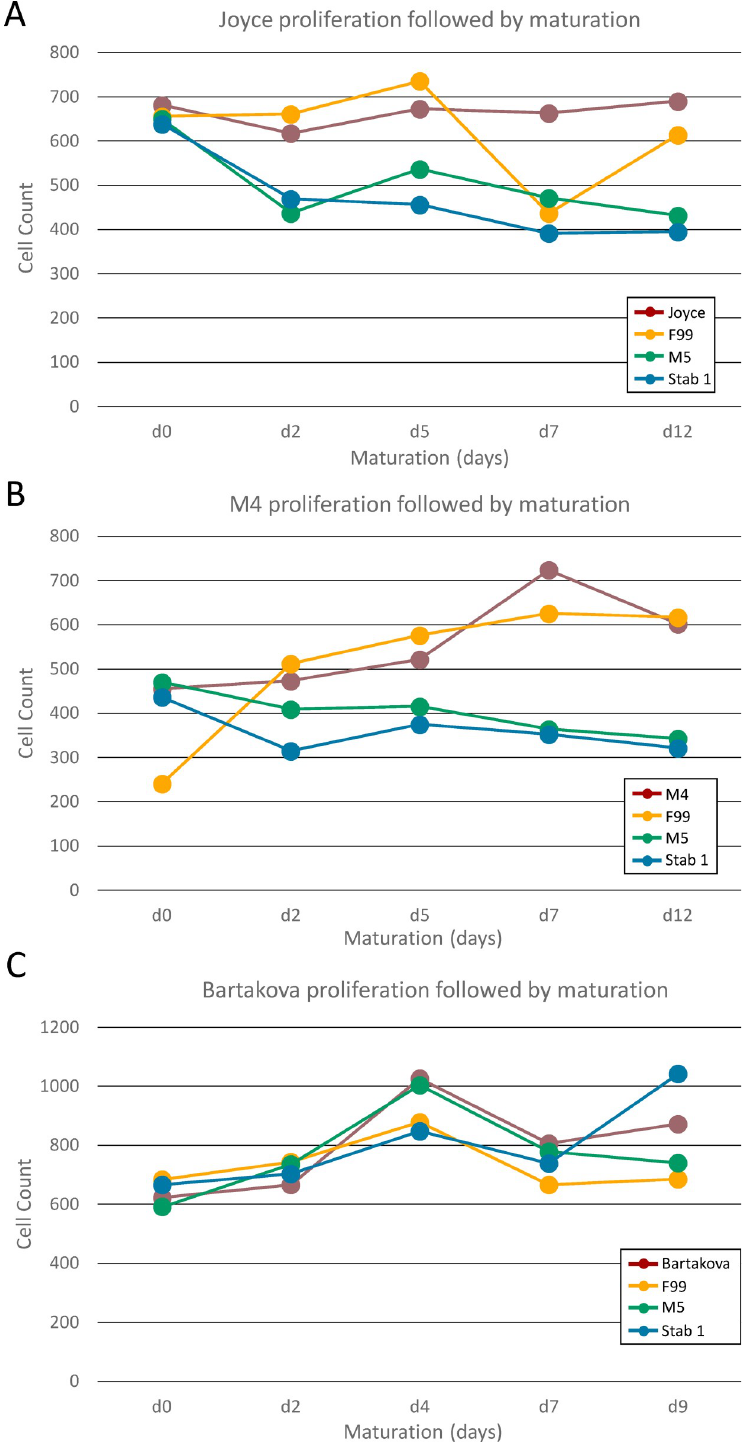
Fig 2. HCEC proliferation in maturation media. HCECs maintained in Joyce (A), M4 (B) or Bartakova (C) proliferation media showed a slight increase in cell density during the maturation phase (day 0–12). Similar results were observed when cells were switched from proliferation media to F99 maturation media. (A, B) In contrast, HCECs incubated in Stabilization 1 (Stab 1) or M5 maturation media for 12 days showed a slight decrease in cell density indicating that cells were not in a proliferative phase. (C) HCECs originally expanded in Bartakova proliferation media either maintained or continued to proliferate in F99, Stabilization 1, or M5 maturation media. https://doi.org/10.1371/journal.pone.0258006.g002 PLOS ONE | https://doi.org/10.1371/journal.pone.0258006 September 29,